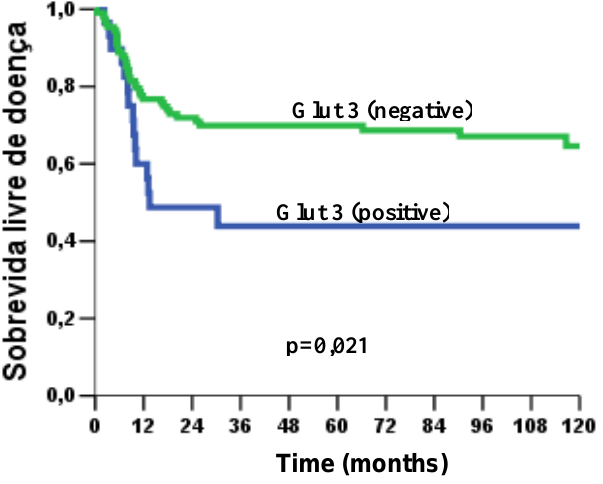
Figure 5. Kaplan – Meier curve of disease - free survival as a function of GLUT3 staining pattern ( p = 0.021).